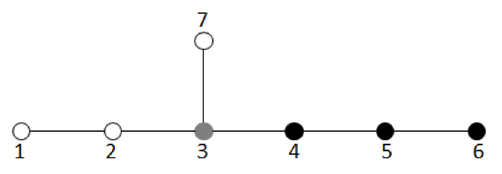
Figure 1 . The Dynkin diagram of E 7 . The Dynkin node labelled i corresponds to the exceptional divisor D . The solid nodes are the ones we break to get the Standard Model gauge group and chiral i matter. Node 3 (in gray) is broken by remainder flux while the others are broken by vertical